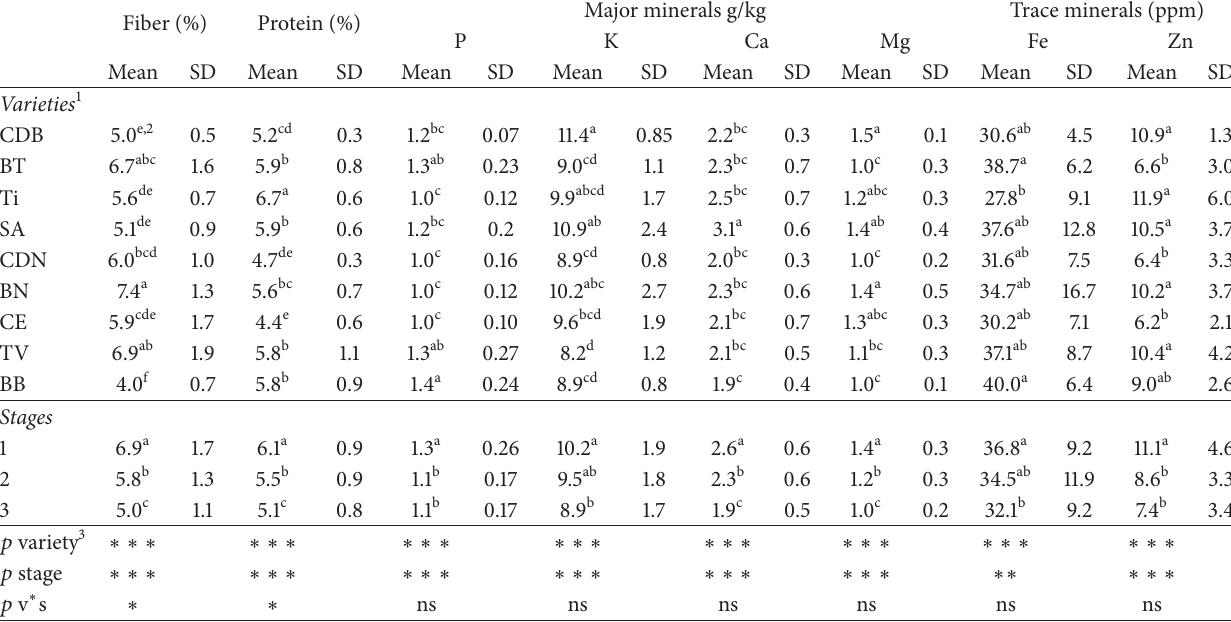
Table 4: Concentrations of protein, crude fiber, and main minerals according to fig tree varieties and commercial ripening